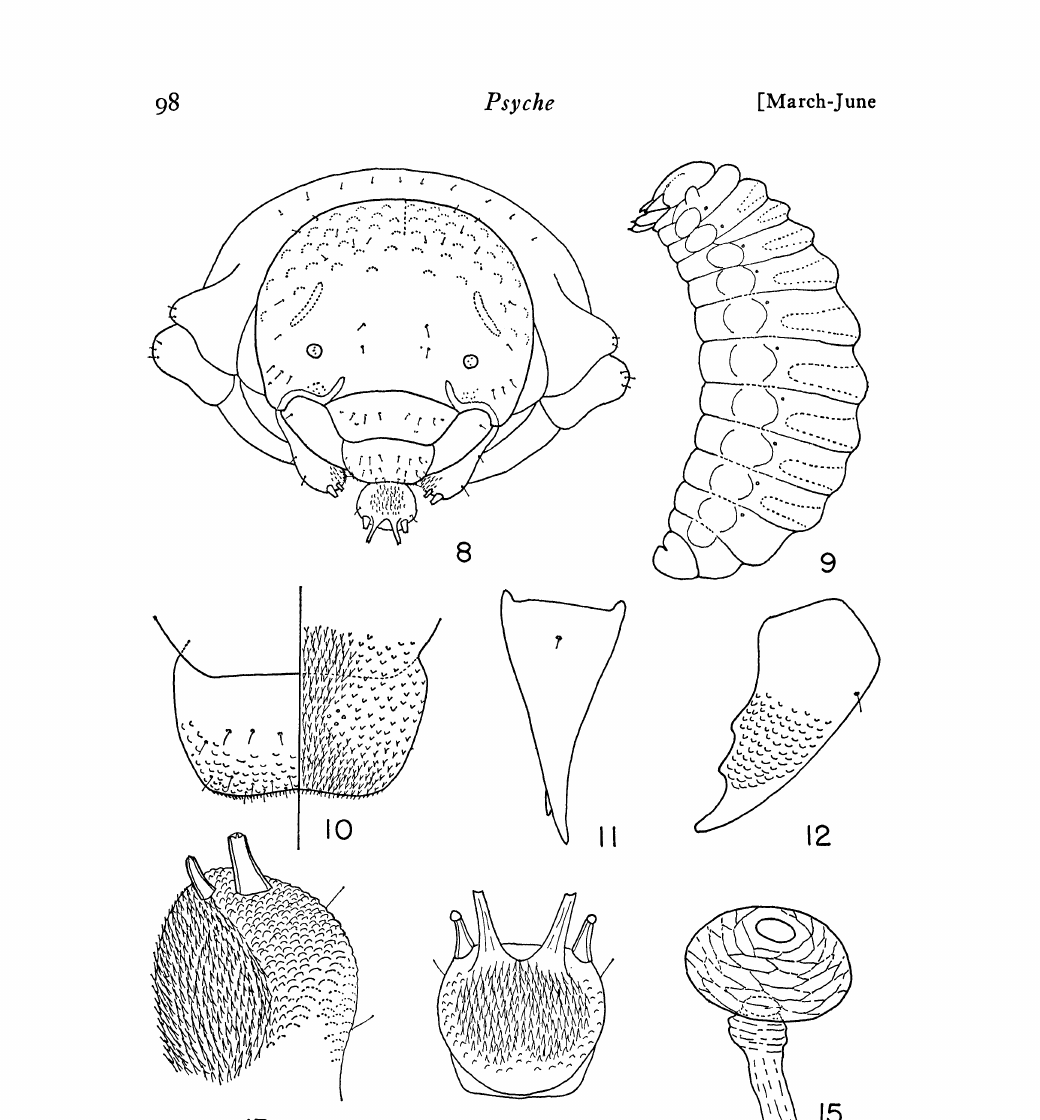
Figs. 8-15. Mature larva of Bothynostethus distinctus Fox. 8. Head in rontal view. 9. Body in side view. 10. Labrum (left) and epipharynx (right). 11. Mandible in side view. 12. Mandible in dorsal view. 13. Dorsal view of maxilla. 14. Dorsal view of prementum of labium. 15. Thoracic